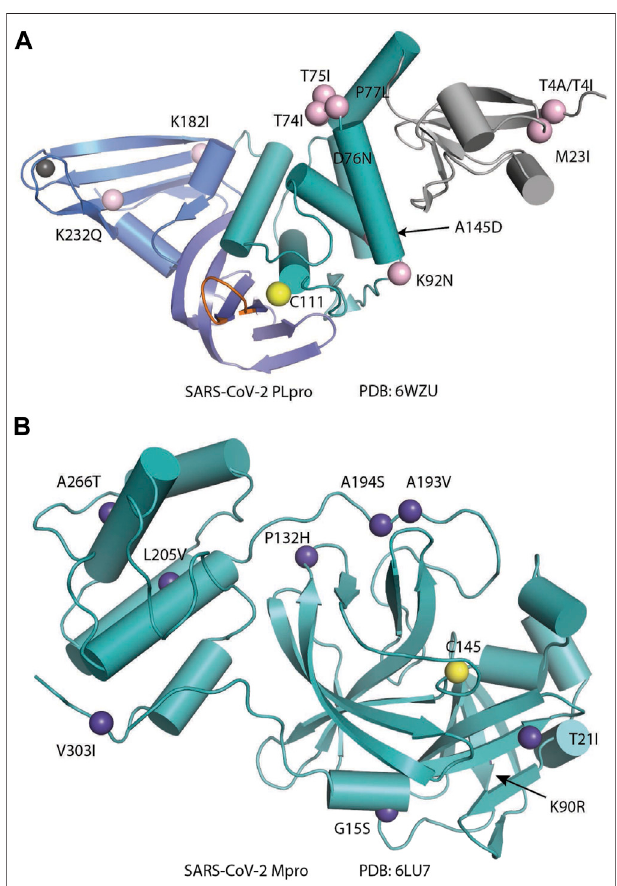
FIGURE 16 | Structural mapping of mutations from variants of concern. (A) PLpro and (B) Mpro are shown as cartoon representation, with VOC mutated residues shown as spheres. The catalytic cysteines are shown as yellow